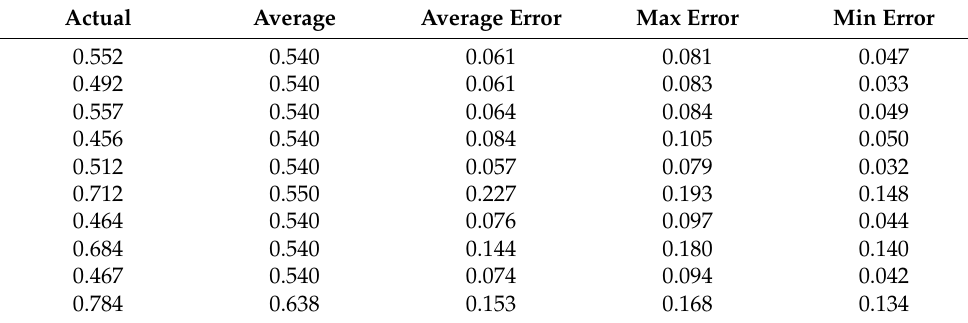
Table A47. Set 1, trials 31–40 data (single 0.5 PR value).